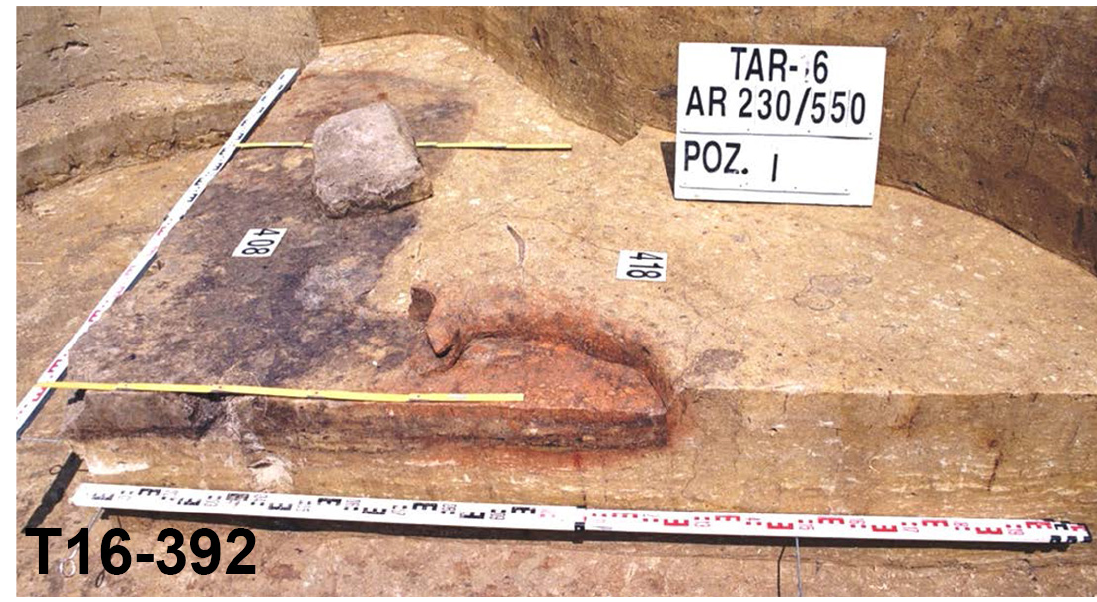
Figure 10: Feature 408 (remains of oven) inside the sunken-floored building 392, Targowisko site